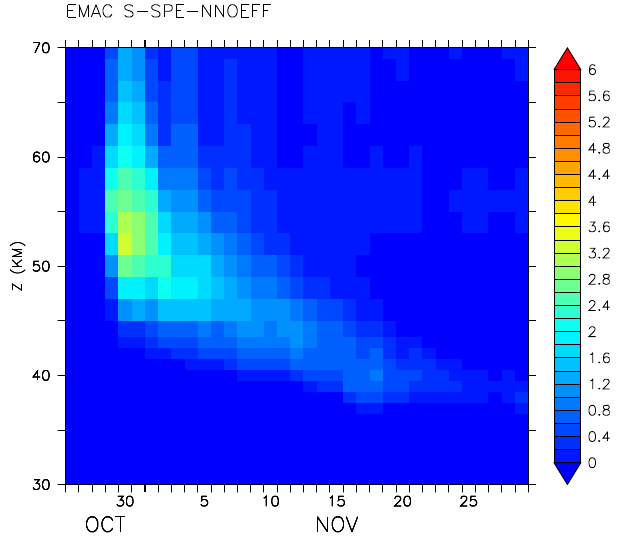
Fig. 11. Same as Fig. 10 but for N 2 O changes